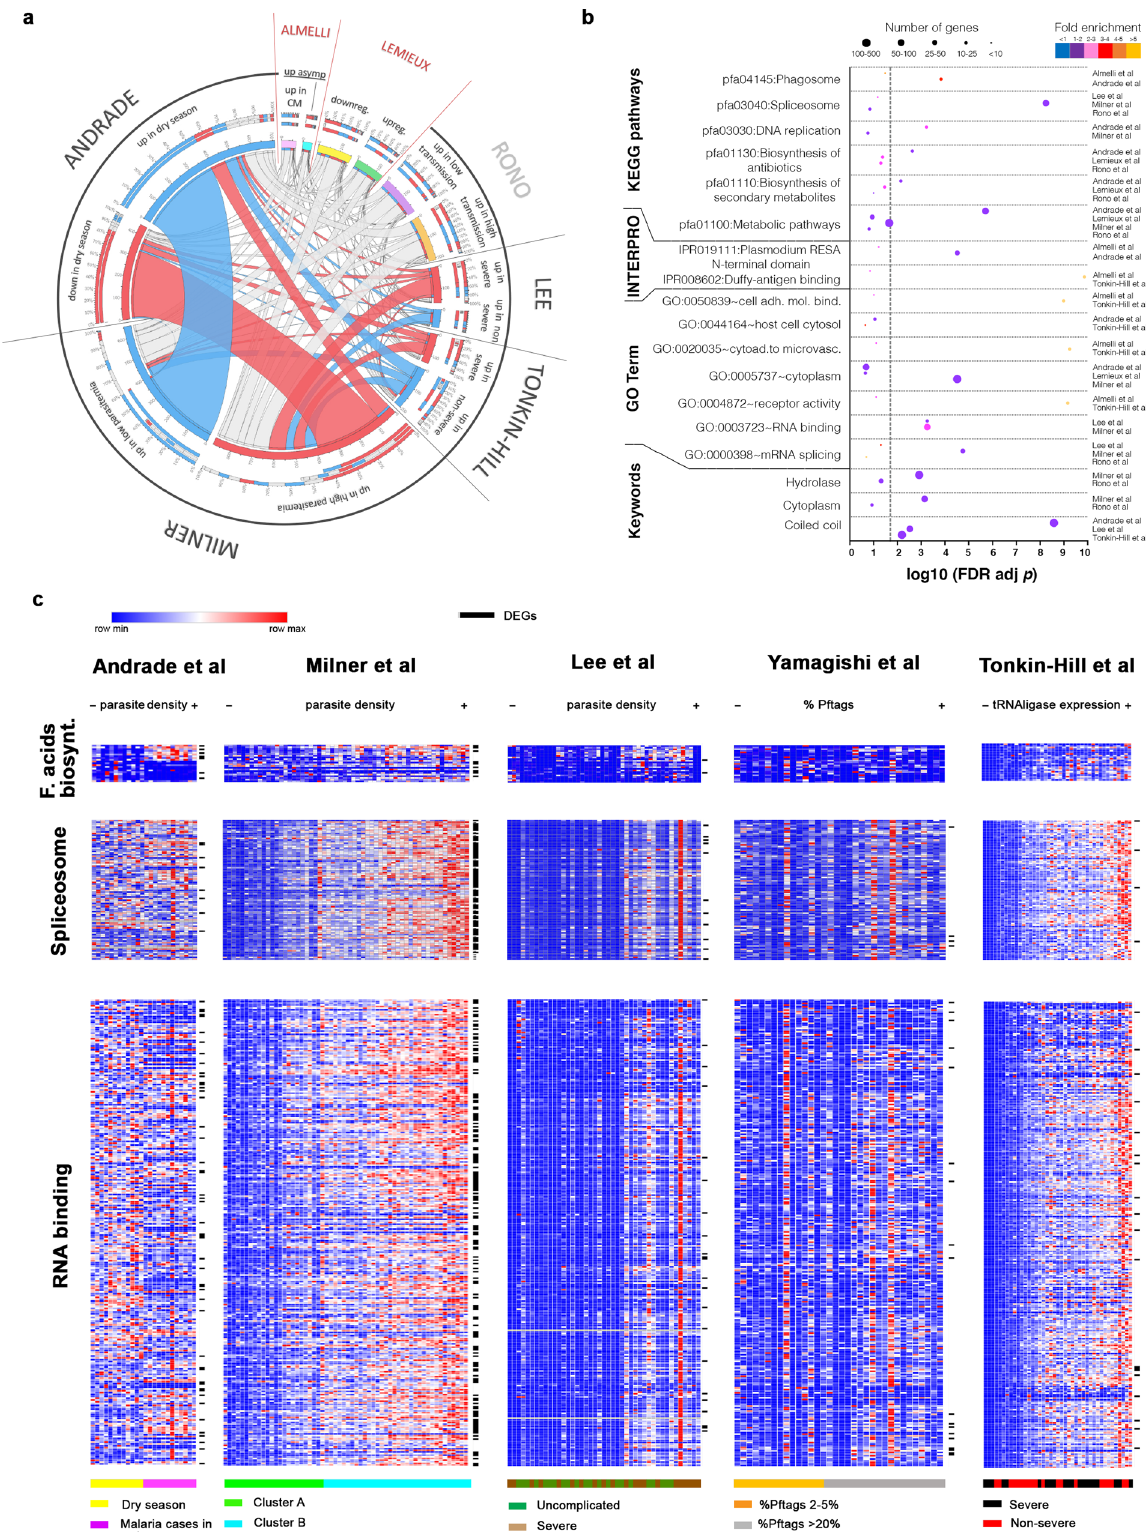
(Fig. 2c and Supplementary Data 2). Also estimating the proportion of developmental stages composing each sample of Andrade et al., but this time using their entire transcriptional pro fi le through a mixture model proposed by Tonkin-Hill et al. 17 , we obtained further evidence that low parasitaemia samples in the dry season contained P. falciparum trophozoites, while malaria cases samples in the